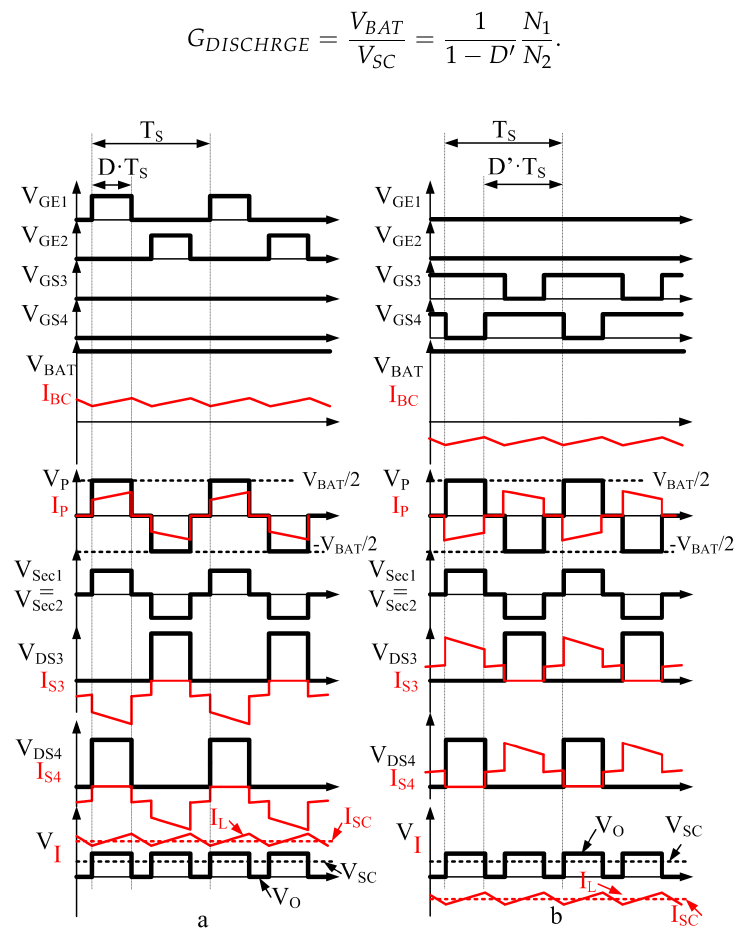
Figure 3. Main voltage (black) and current (red) waveforms of the half-bridge current-source (HBSC) for charging ( a ) and discharging ( b ) operation